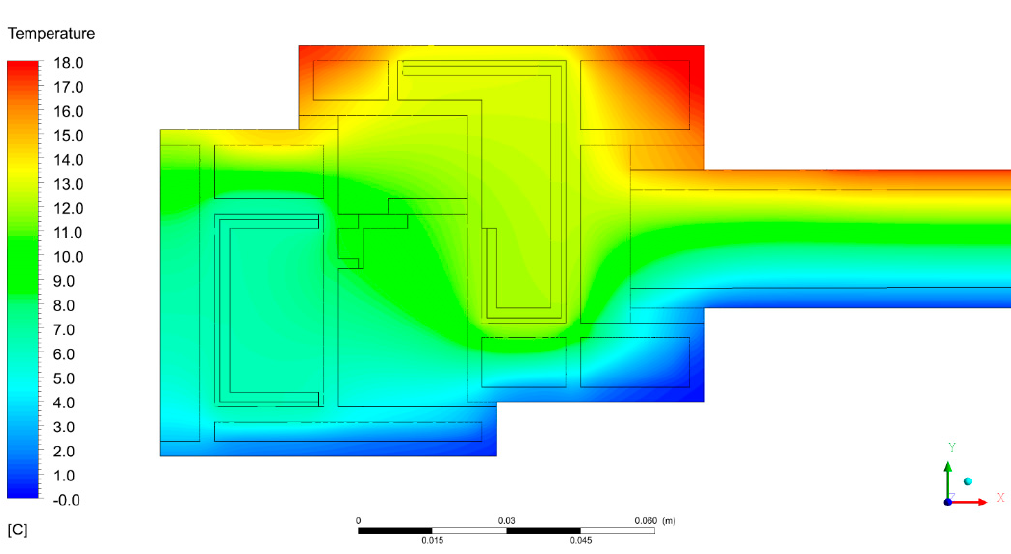
Figure 3. Temperature distribution on PVC frame, example I3 from ISO 10077-2.